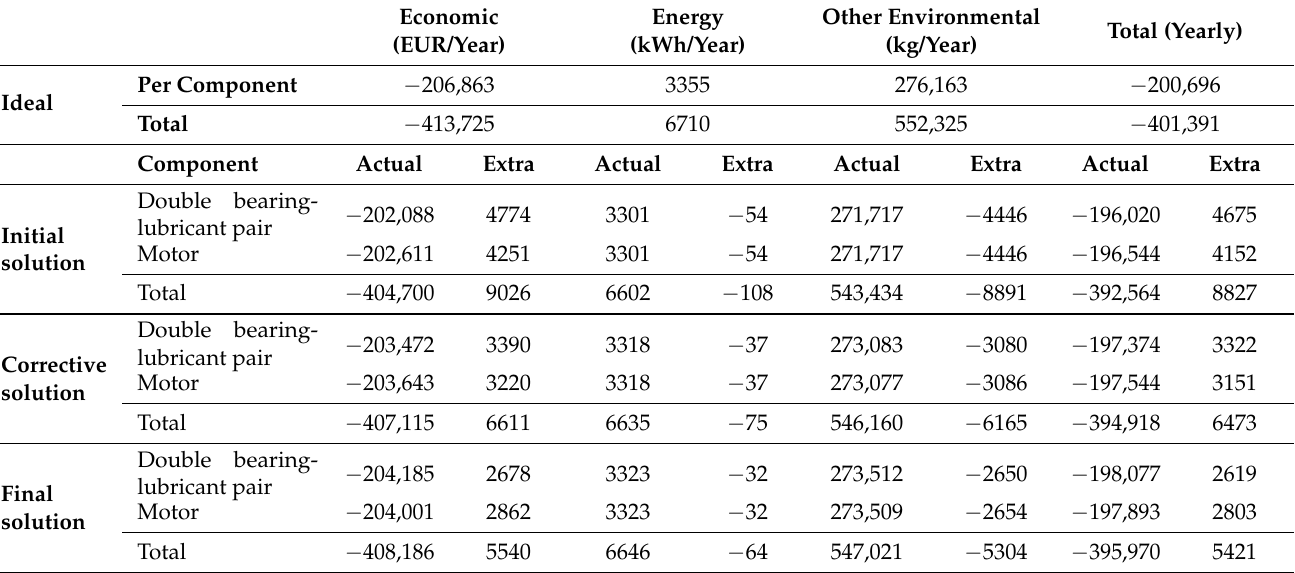
Table 25. KPIs yielded from training the model with standalone uncoated roller for the bleaching machine (ZORLUTEKS).